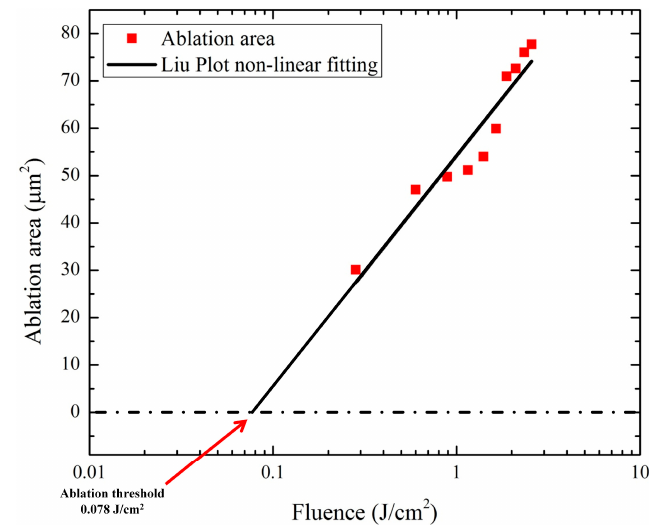
Figure 2. Invar ablation threshold experimental results and calculation (Liu plot non-linear fitting).